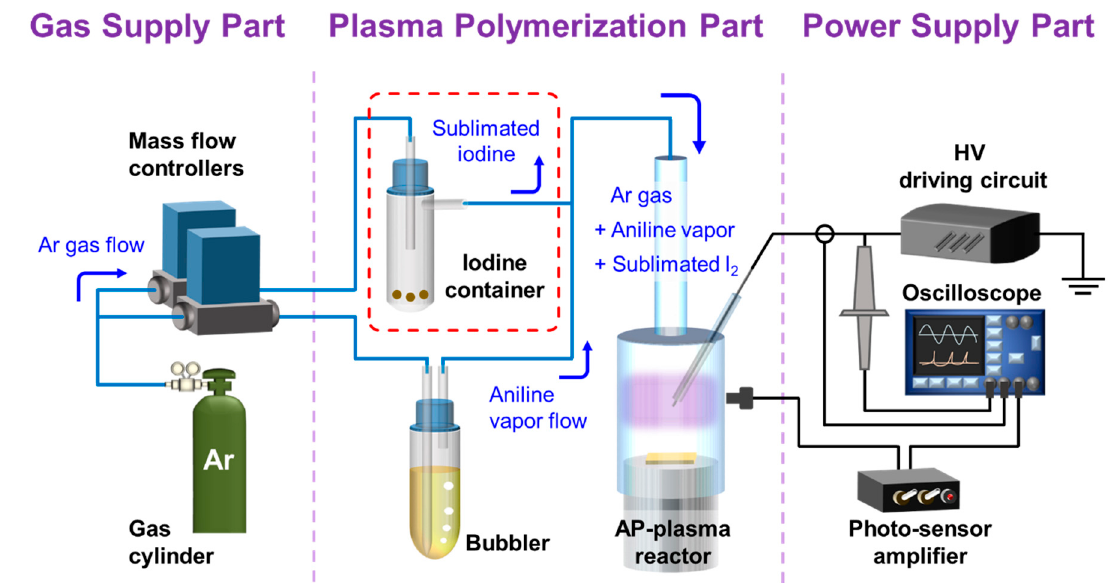
Figure 2. Schematic diagram of the fully-assembled system for the in-situ I 2 -doped AP plasma polymerization procedure.